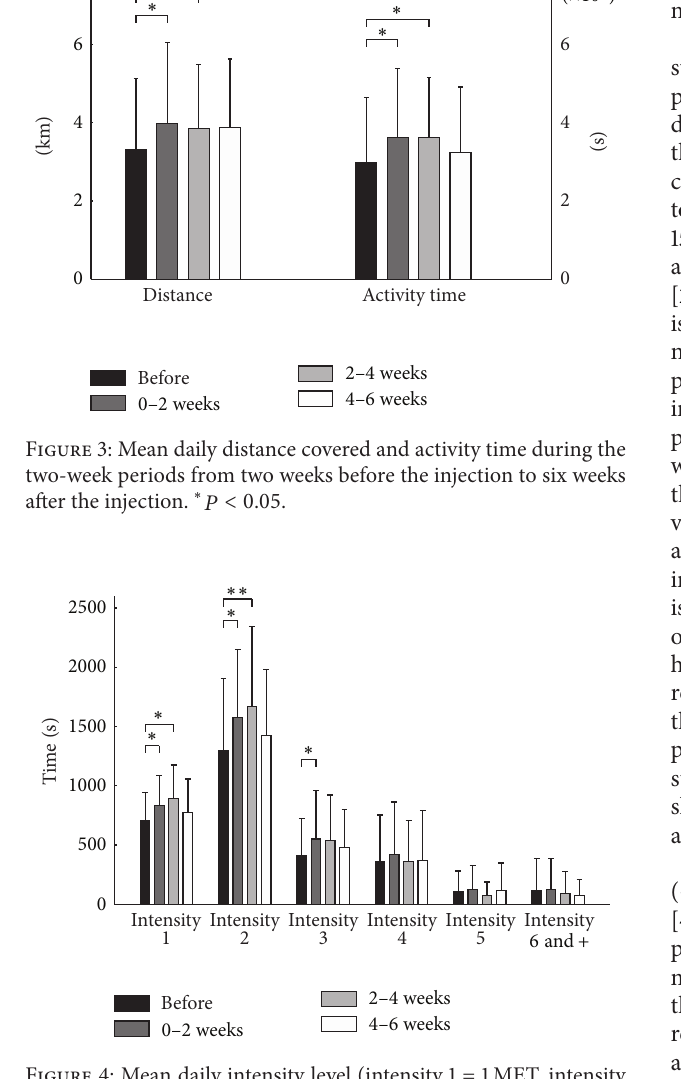
Figure 4: Mean daily intensity level (intensity 1 = 1MET, intensity 2 = 2 METs, and so on) of physical activity during the two-week periods from two weeks before the injection to six weeks after the injection. ∗ 𝑃 < 0.05 ; ∗∗ 𝑃 < 0.01